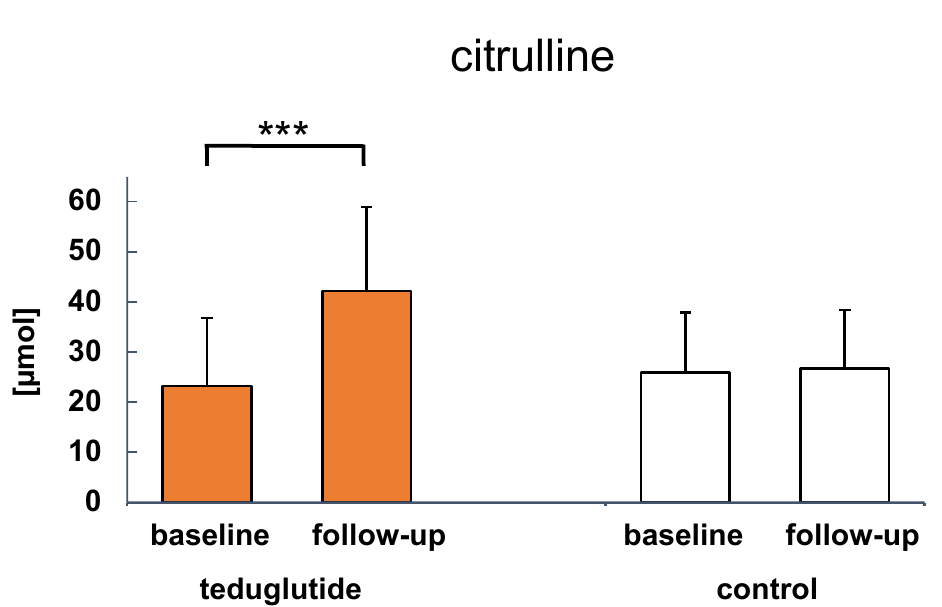
Figure 5. Plasma citrulline levels for teduglutide-treated patients and non-treated controls ( n = 13 and n = 11; n = 11 and n = 14, respectively). Significant changes are indicated as: *** p < 0.001 vs. baseline values. Presented are